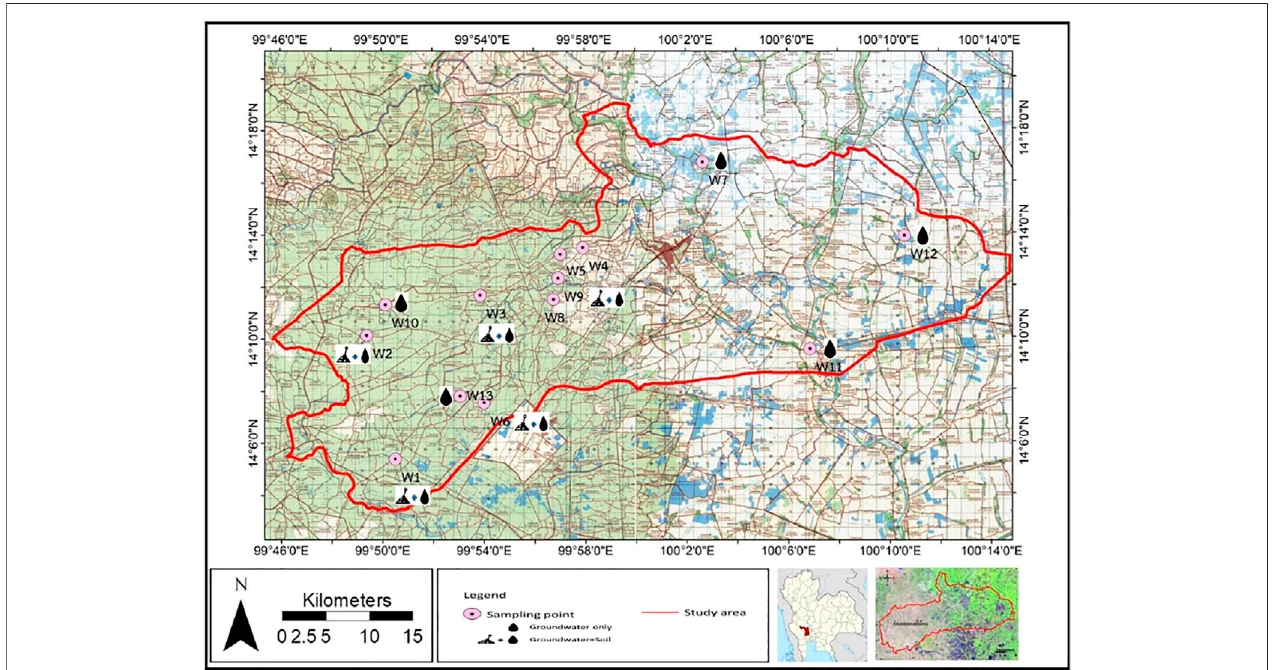
FIGURE 1 | Study area and groundwater sampling